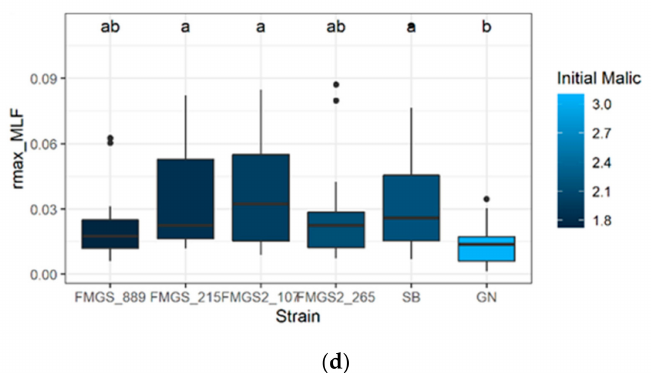
Figure 7. Malolactic fermentations with high malic consumer strains. ( a ) Malic acid concentration (g/L) according to the time (h) for each stain used in the 6 inoculated wines. ( b ) Time (h) to achieve 50% of the MLF according to the strains used. ( c ) Correlation between the time at 50% of the MLF (t_MLF50) and the malic acid concentration (g/L). ( d ) Maximum fermentation rate (g/L/h) according to the strains